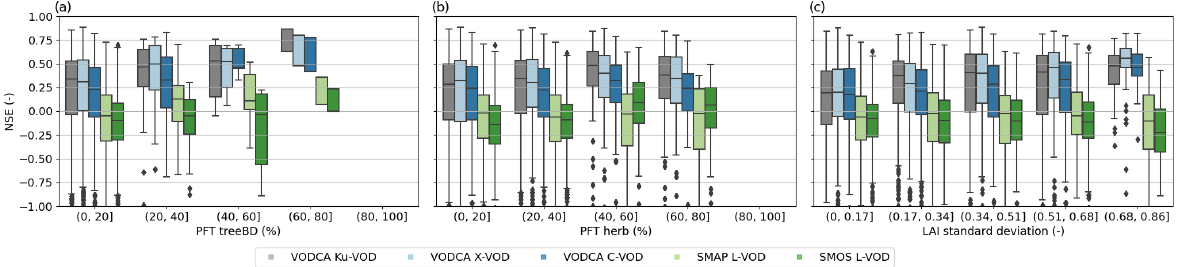
Figure 4. Spatial Nash–Sutcliffe model efficiency coefficient (NSE) based on the global random forest model computed with monthly data stratified by the land cover homogeneity of a pixel exemplary shown (a) for the tree cover class plant functional type deciduous broadleaf trees (PFT treeBD) and (b) for herbaceous vegetation (PFT herb). Note that no data with 80%–100% of these specific land cover classes are available. Panel (c) shows NSE stratified by the seasonality of LAI expressed as the intra-annual standard deviation of LAI. Please note that sparse data samples or even missing data result in missing boxes or whiskers.